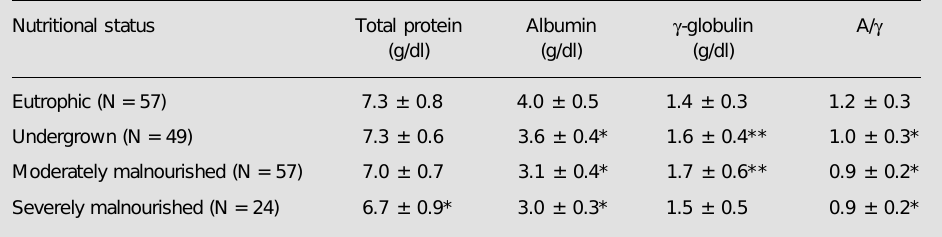
Table 2 – Plasma total protein, albumin (A) and g -globulin ( g ) of the children in the study. Data are reported as mean ± SD. *Albumin and A/ g significantly lower than in the eutrophic group (P<0.05; Student t -test); ** g -globulin significantly higher than in the eutrophic group (P<0.05; Student t -test). Nutritional status